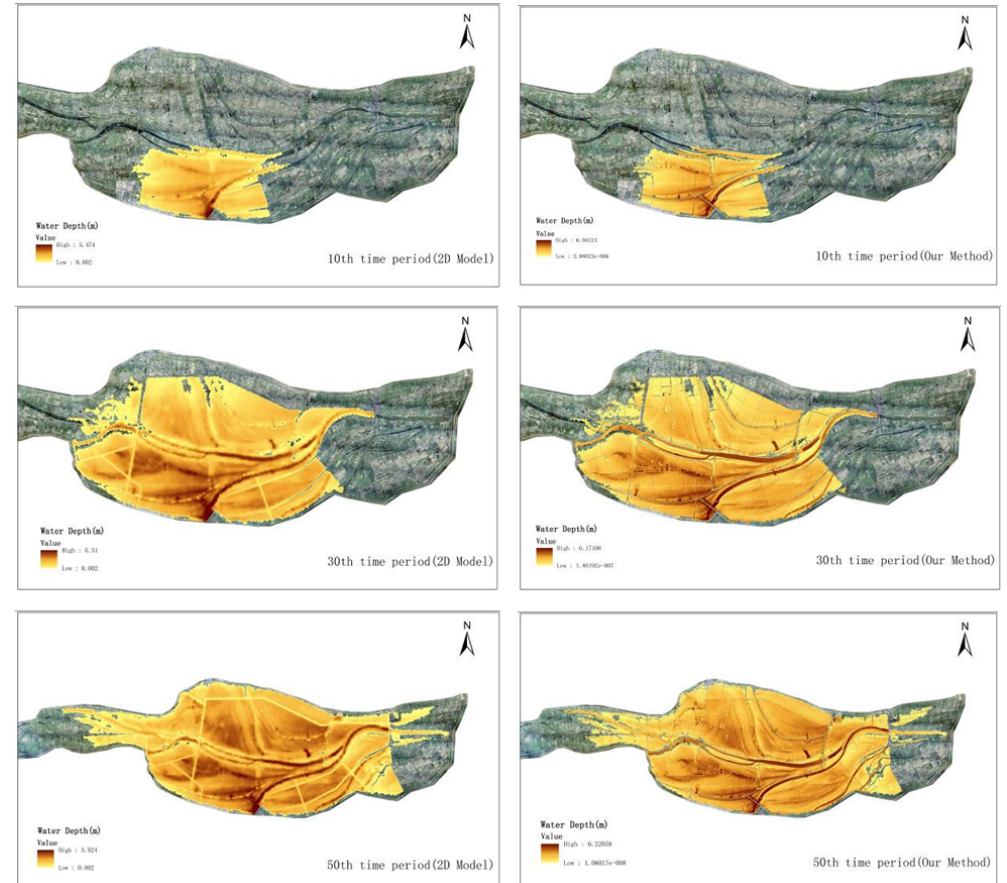
Figure 10. The scheme for the inundation process in the Gongshuangcha detention basin during three different time